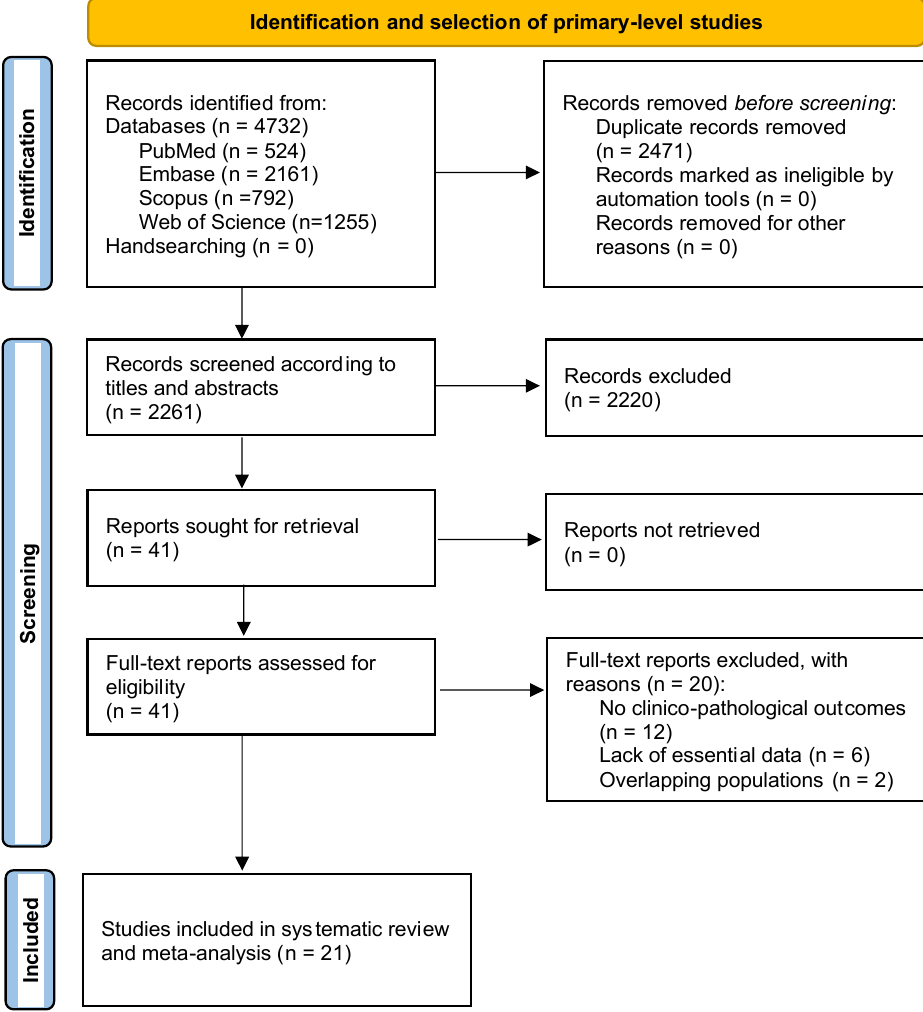
Figure 1. Flow diagram showing the identification and selection process of the study sample, analyzing primary-level studies researching the prognostic and clinicopathological significance TERT upregulation in OSCC. Table 1. Summary of the main characteristics of the study. Table S2 (Supplementary Materials) exhibits in detail the characteristics of each primary-level study included in this systematic review and